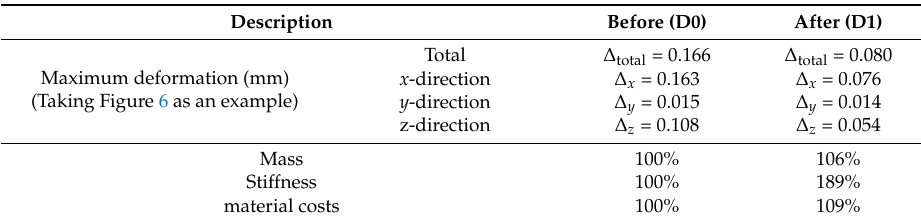
Figure 6. Comparison of the portal’s structure and FEA deformation cloud map (taking load 1 as an example) before and after design optimization: ( A ) structure of D0; ( B ) total deformation of D0; ( C ) x -direction deformation of D0; ( D ) y -direction deformation of D0; ( E ) z -direction deformation of D0; ( F ) structure of D1; ( G ) total deformation of D1; ( H ) x -direction deformation of D1; ( I ) y -direction deformation of D1; ( J ) z -direction deformation of D1. Table 6. Comparison of portal’s performance before and after design